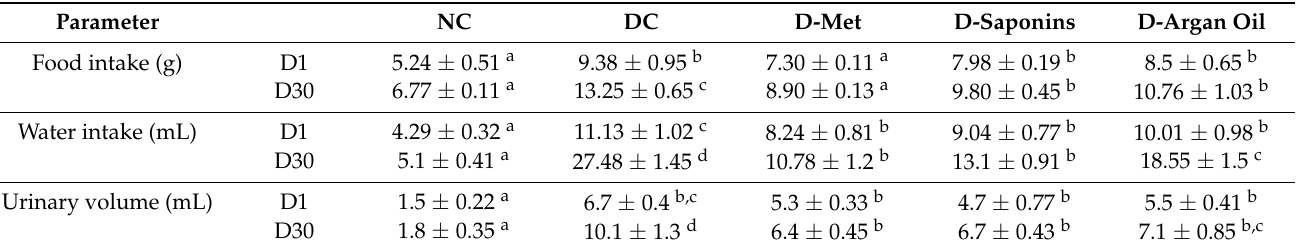
Table 5. Changes in metabolic parameters (food intake, water intake, and urinary volume in groups).